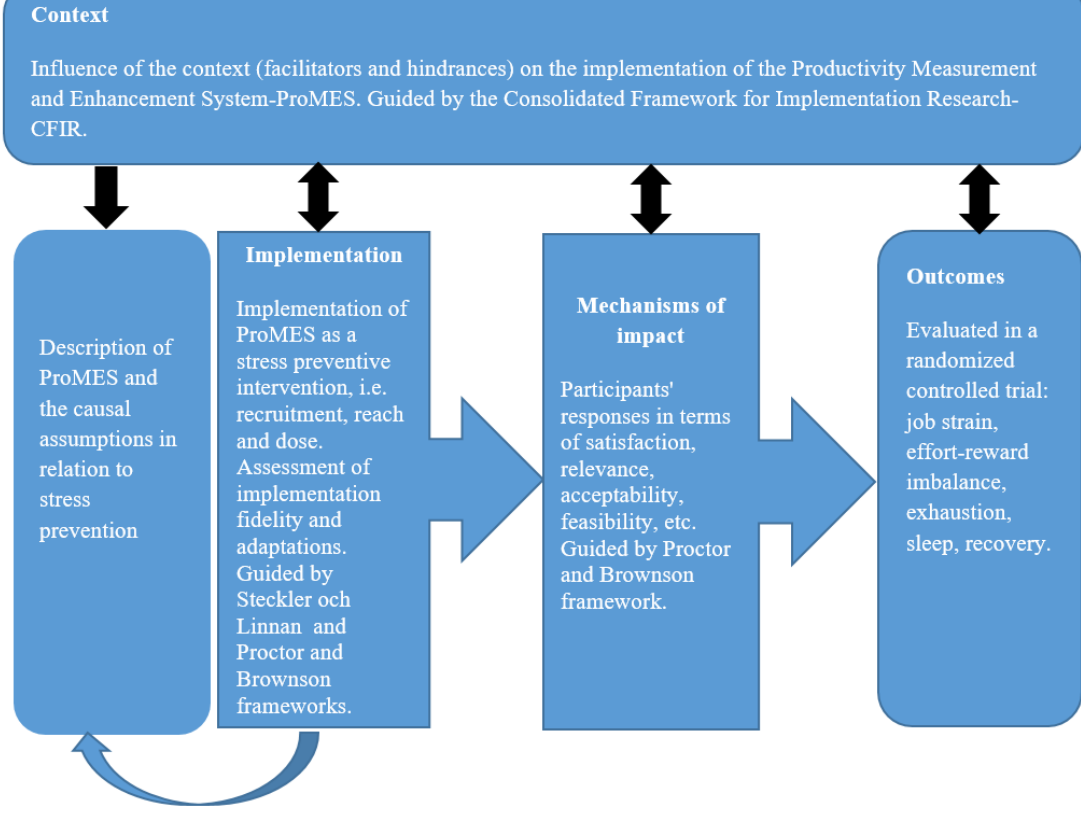
Figure 1. Key functions of the process evaluation and the frameworks used (after UK Medical Research Council (MRC) guidance